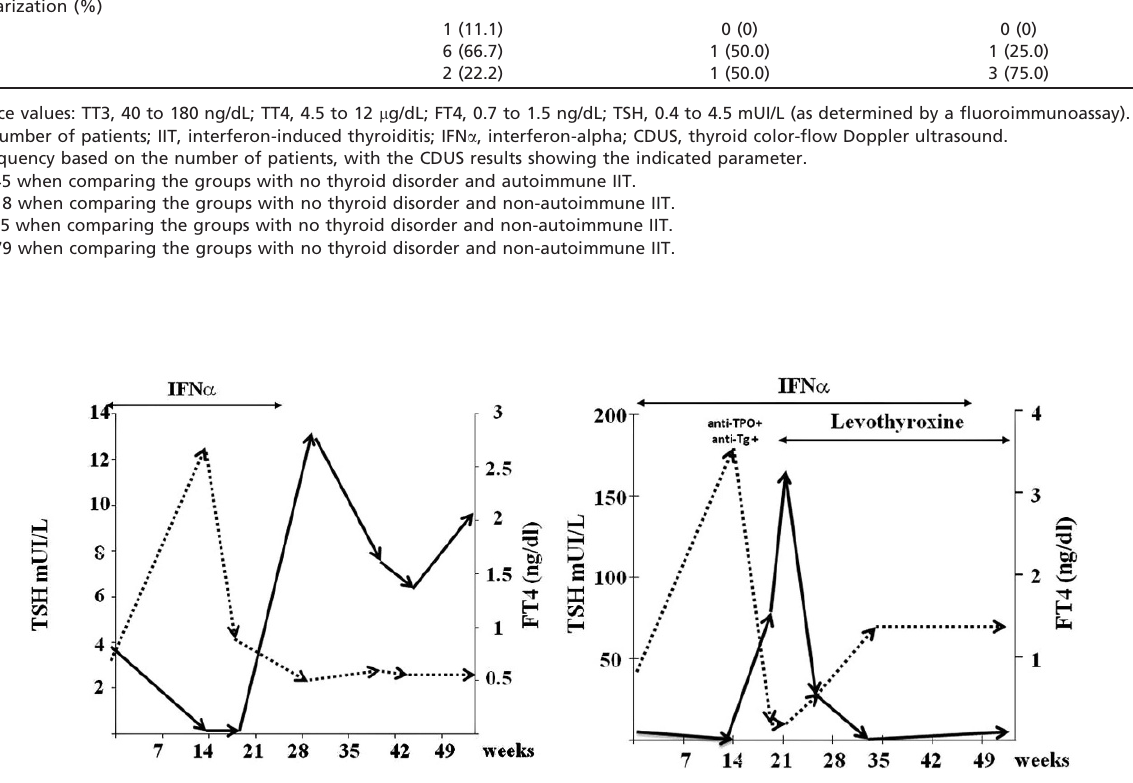
Figure 2 - TSH and FT4 changes during the follow-up of 2 HCV-infected patients with destructive thyroiditis induced by IFN a and ribavirin. Reference values: FT4, 0.7 to 1.5 ng/dL; TSH, 0.4 to 4.5 mUI/L (as determined by a